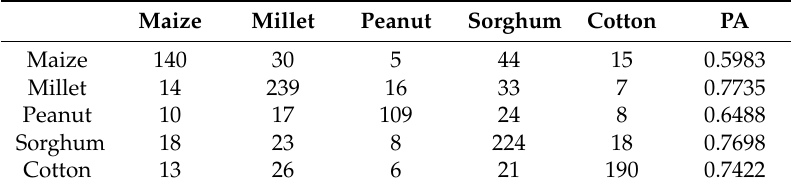
Table 6. Confusion matrix applying a base RF classifier, PA: Producer accuracy per class. Millet